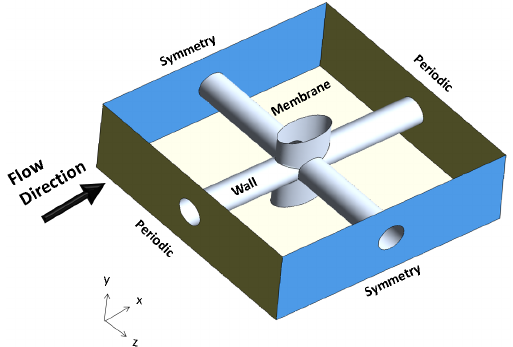
Figure 3. Computational Fluid Dynamics (CFD) model setting.